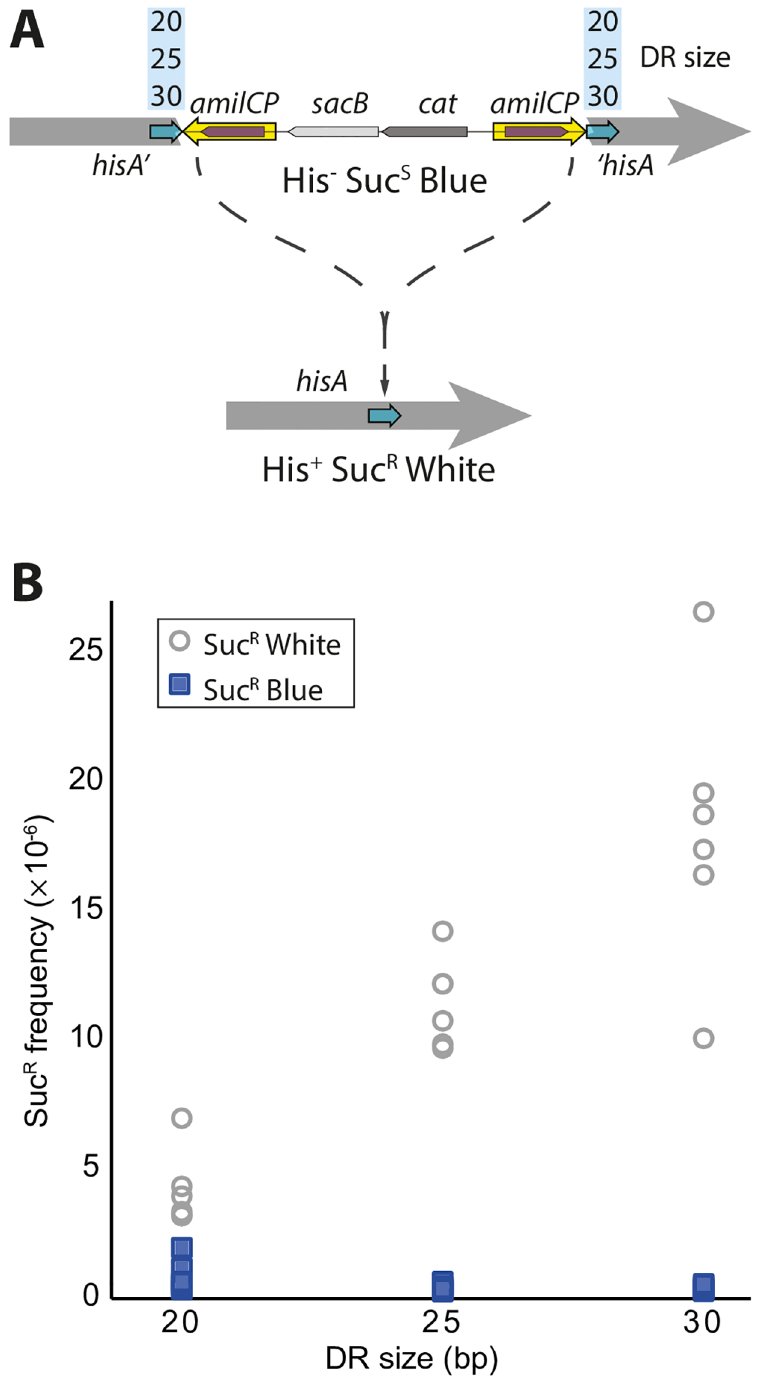
Fig 4. Excision frequencies increasewith increasing DR size. (A) Assay for precise excision. The three DIRex constructs in hisA were identicalexcept for having 20, 25 or 30 bp DRs (light blue arrows). When the DIRex intermediate is present the hisA gene is interrupted,and the cell is unableto grow in medium lacking histidine(His - ). AmilCP confers blue color and SacB causes sensitivity to sucrose. Selectionon sucrose selectionplates allows only cells lacking a functional sacB gene to grow. If the cassette is excised a functional wild-typecopy of hisA is restored and the cells lose the blue color and becomes sucrose resistant. For a more detailedview of the primers used in this experiment, see panel B in S1 Fig. (B) Frequencies of segregants (white) and false positives (blue) in six independentcultures of each of the three constructs.